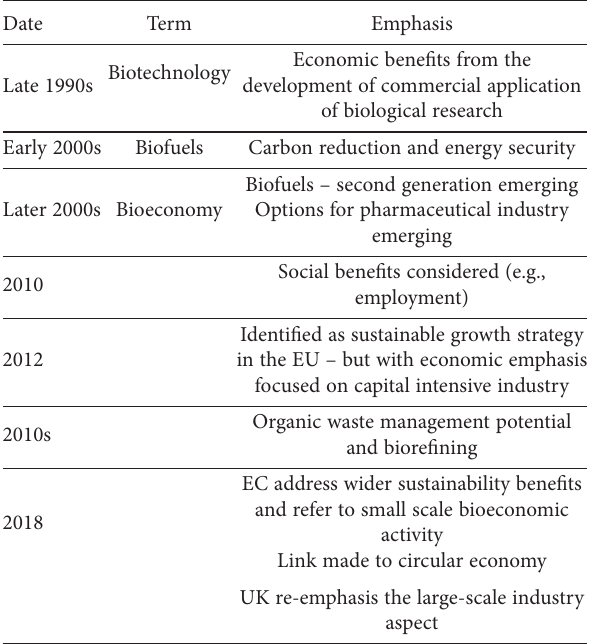
Table 2. Bioeconomy timeline. This table summarises the key con- cepts relating to the bioeconomy to provide a timeline. For sources, see the